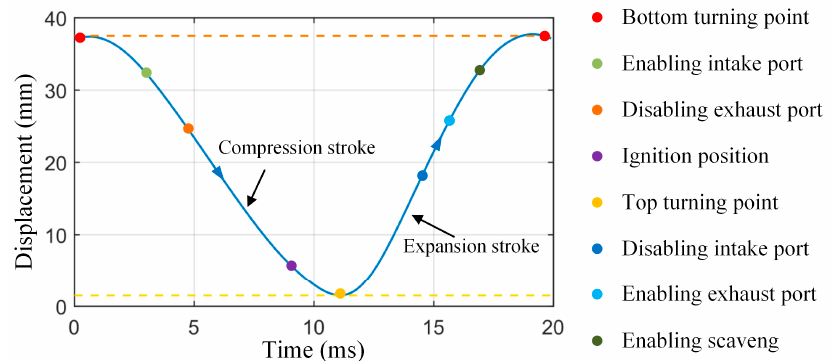
Figure 2. Two-stroke working cycles of the FPEG.